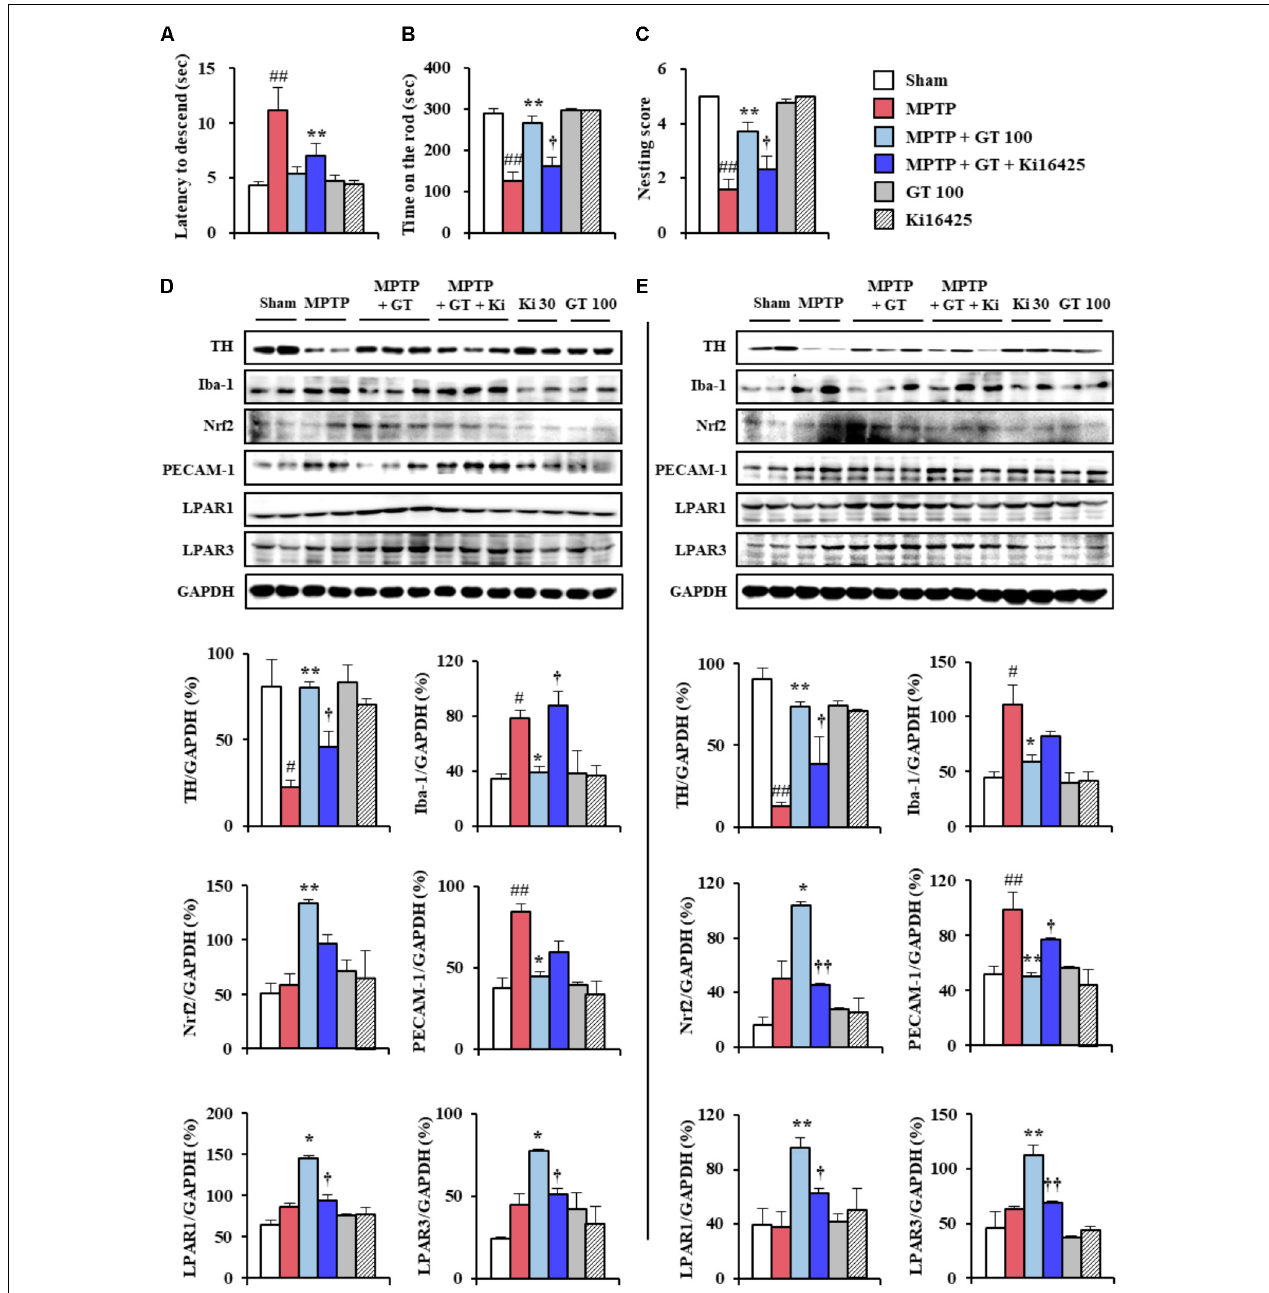
FIGURE 7 | Multi-target effects of gintonin in MPTP-induced neurotoxicity were neutralized by Ki16425, an LPAR1/3 antagonist. (A–C) Mice ( n = 8 per group) were orally administered with gintonin or saline 1 h before the first MPTP injection. Ki16425 was used once daily 30 min before gintonin treatment. Pole test (A) , rotarod performance test (B) , and nest-building behavior test (C) were conducted 3, 3, and 1 days after the last MPTP-injection. (D,E) Immunoblot analysis of TH, Iba-1, Nrf2, PECAM-1, LPAR1, and LPAR3 was conducted in SNpc (D) and striatum (E) obtained from each group ( n = 2–3 per group) 7 days after MPTP injection. The top panels illustrate representative Western blots. ANOVA test; # p < 0.05 and ## p < 0.01 vs. Sham group. ∗ p < 0.05 and ∗∗ p < 0.01 vs. MPTP group. † p < 0.05 and †† p < 0.01 vs. MPTP + GT 100 mg/kg/day